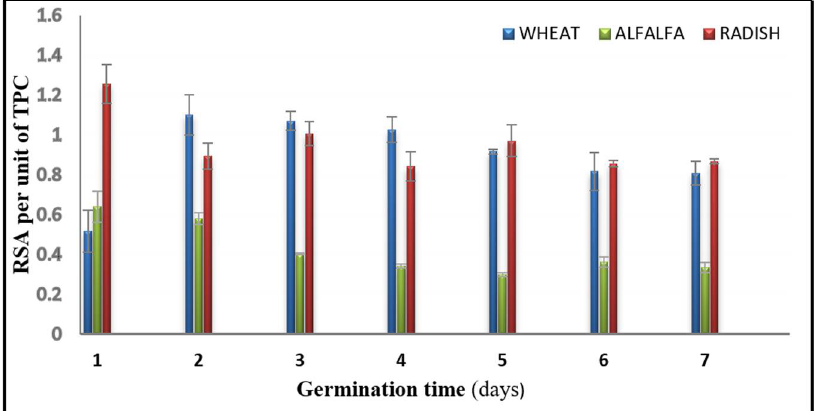
Figure 3. Radical scavenging activity per unit of polyphenols over 7 days of germination for the wheat, alfalfa, and radish sprouts.